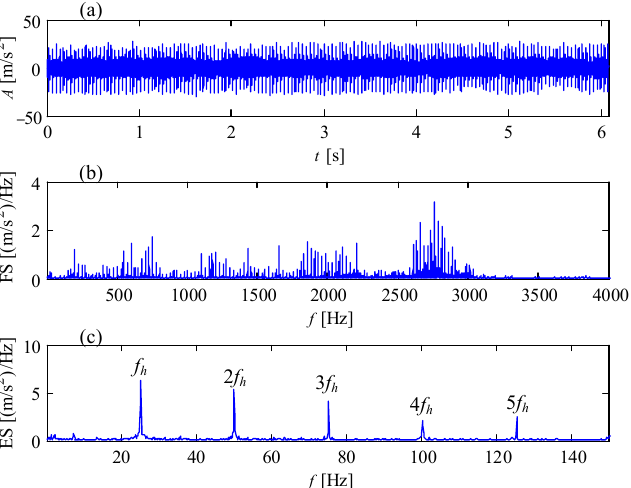
Figure 12. Vibration signal of the broken pinion on high-speed shaft: ( a ) temporal signal; ( b ) Fourier spectrum; ( c ) envelope spectrum.